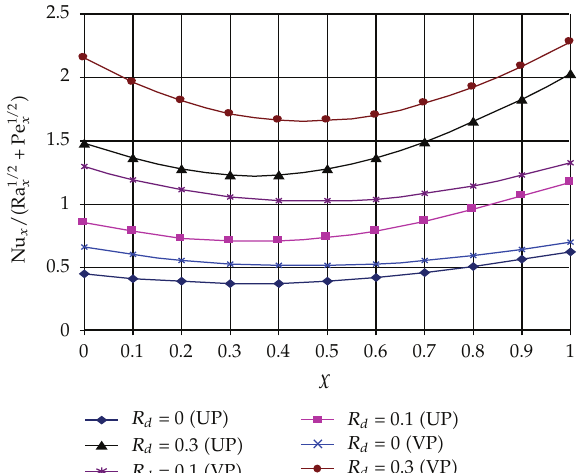
Figure 4: Comparison of values Nu x / (cid:3) Ra 1 / 2 x (cid:9) Pe 1 / 2 x (cid:6) for R and χ with m (cid:8) 0 . 2451 and H (cid:8) 2 . 0 for both UP and VP